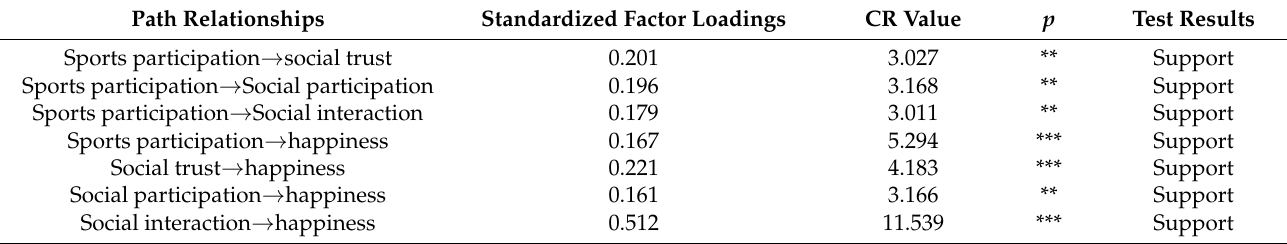
Table 5. Shows the outcomes of each path’s